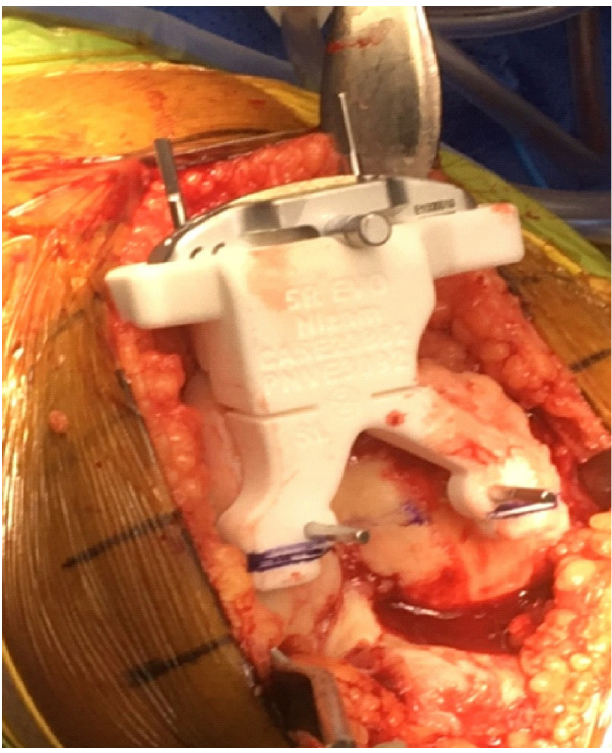
Figure 2. The PSI cutting block placed accurately on the femoral surface and pinned. An intraoperative image showing the patient speci fi c cutting block placed accurately on the distal femoral surface (cid:3) fl exion and rotation checked. The block contains the cutting jig in situ. The block contains information related to the